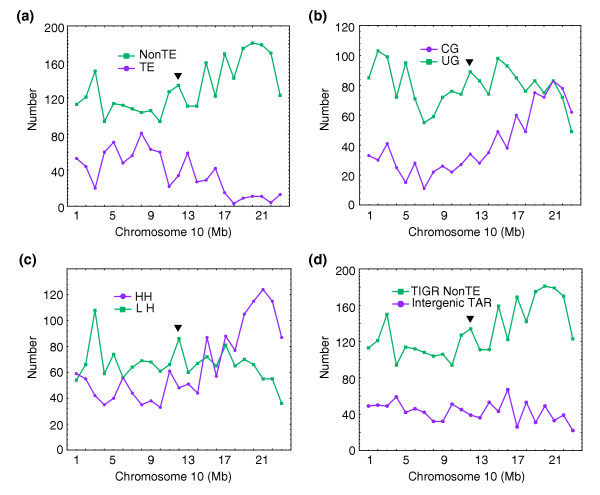
Chromosome-wide distribution of gene models and chromosomal elements. (a) Distribution of TIGR japonica nonredundant protein-coding gene models (non-TE) and transposable element-related models (TE) in 1-Mb windows across chromosome 10. The division between domain I and II is indicated by the arrowhead. Note that the centromere is located at around 7 to 8 Mb in chromosome 10. (b) Distribution of BGI japonica CG and UG models in 1-Mb windows across chromosome 10. (c) Distribution of BGI japonica HH and LH models in 1-Mb windows across chromosome 10. (d) Numbers of the TIGR japonica nonredundant protein-coding gene models (TIGR Non-TE) and tiling array-detected intergenic TARs in 1-Mb windows across chromosome 10.